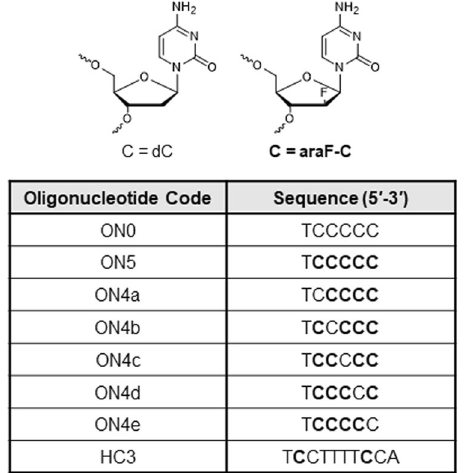
Fig. 1 Oligonucleotide sequences used in this study. i-Motif forming oligonucleotides are listed in the table, and the chemical structures of dC and the substituent araF-C are represented above the table.